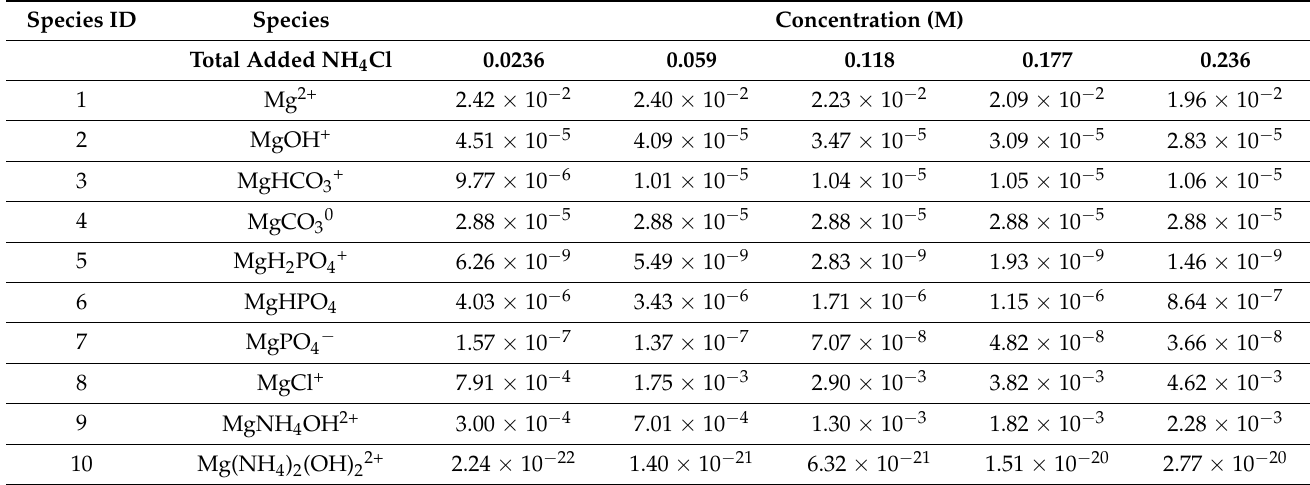
Table A5. Concentrations of dissolved and solid species for Mg char at pH 9 calculated using MINEQL+. Values in rows 22, 24, and 26 were